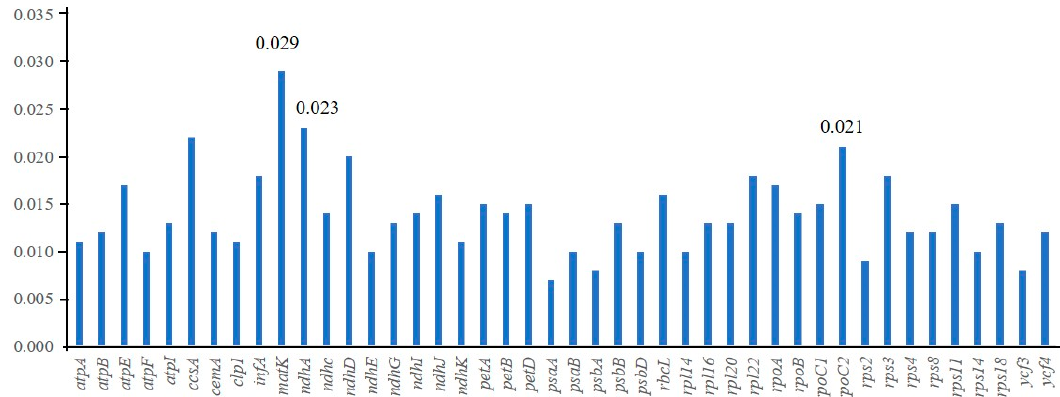
Figure 6. The K2P values for individual protein coding genes.